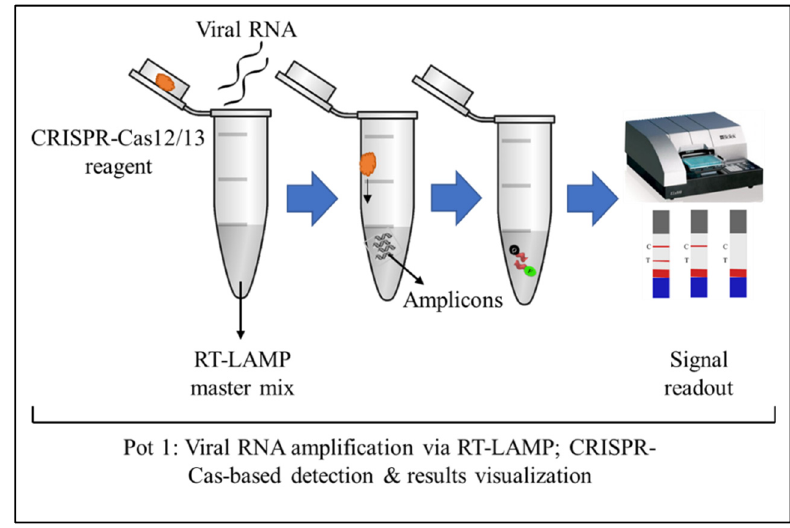
Figure 2. Schematic illustration shows the one-pot reaction for detecting SARS-CoV-2. The viral RNA amplification via RT-LAMP, CRISPR-Cas12/13-based detection, and visualization of the results through the fluorescence assay, all performed in a single tube. Alternatively, the tube can be opened for a lateral flow assay.